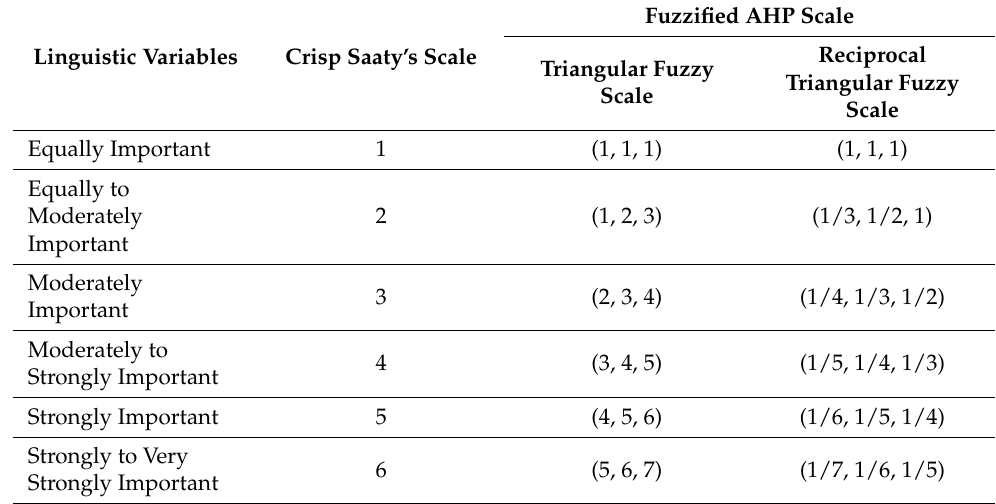
Table 4. Saaty’s Scale for constructing the triangular F-PCMs table by [28]. Linguistic Variables Crisp Saaty’s Scale